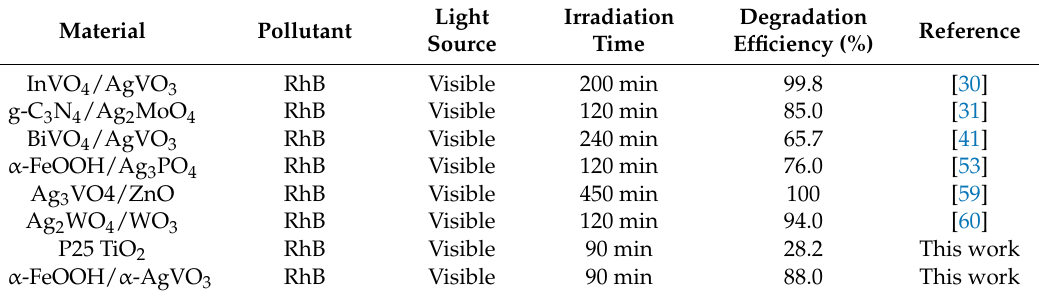
Table 1. Comparison of photocatalytic activity of the α -FeOOH/ α -AgVO 3 nanocomposite with that of other silver-based composite materials in the